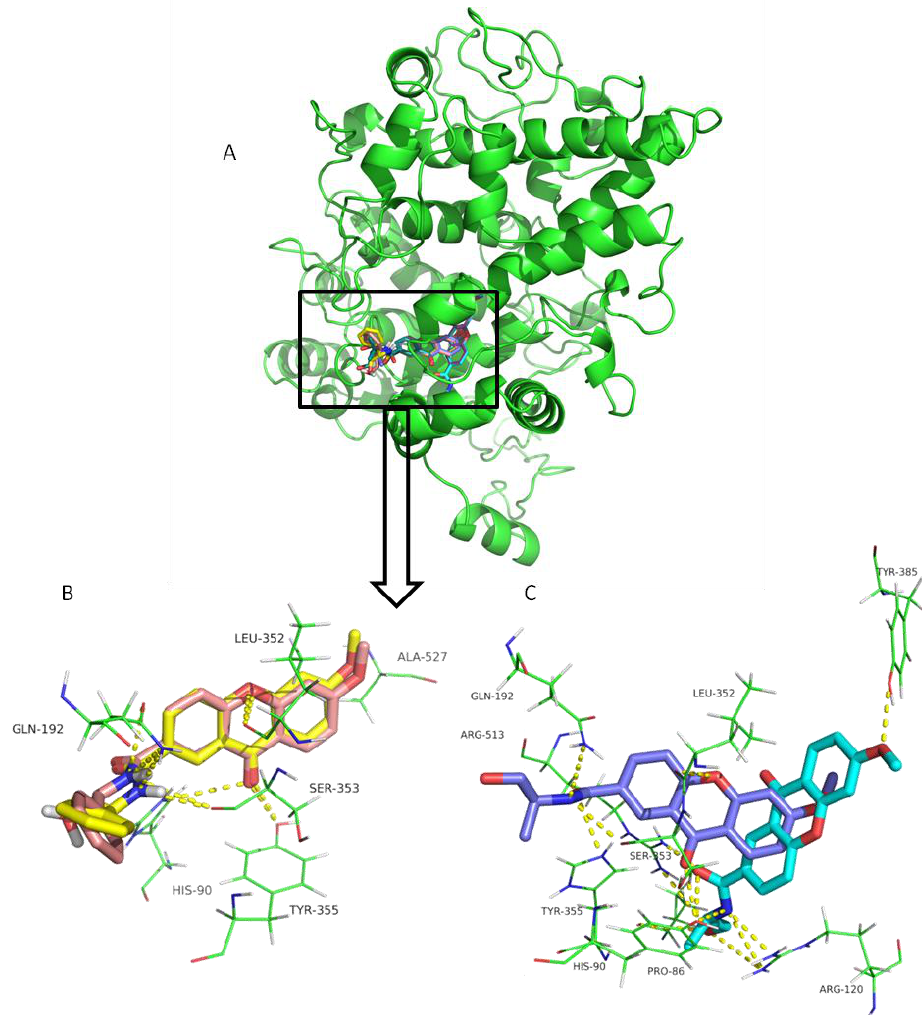
Figure 2. ( A ) COX-2 ribbon representation. ( B ) Comparison of docking poses of CDX1 enantiomers in COX-2 binding site. ( R ) and ( S ) enantiomers are represented in pink and yellow sticks, respectively. ( C ) Comparison of docking poses of CDX3 enantiomers in COX-2 binding site. ( R ) and ( S ) enantiomers are represented in light and dark blue sticks, respectively. Hydrogen interactions are represented as yellow dashes and the residues evolved are represented as green lines and labeled.